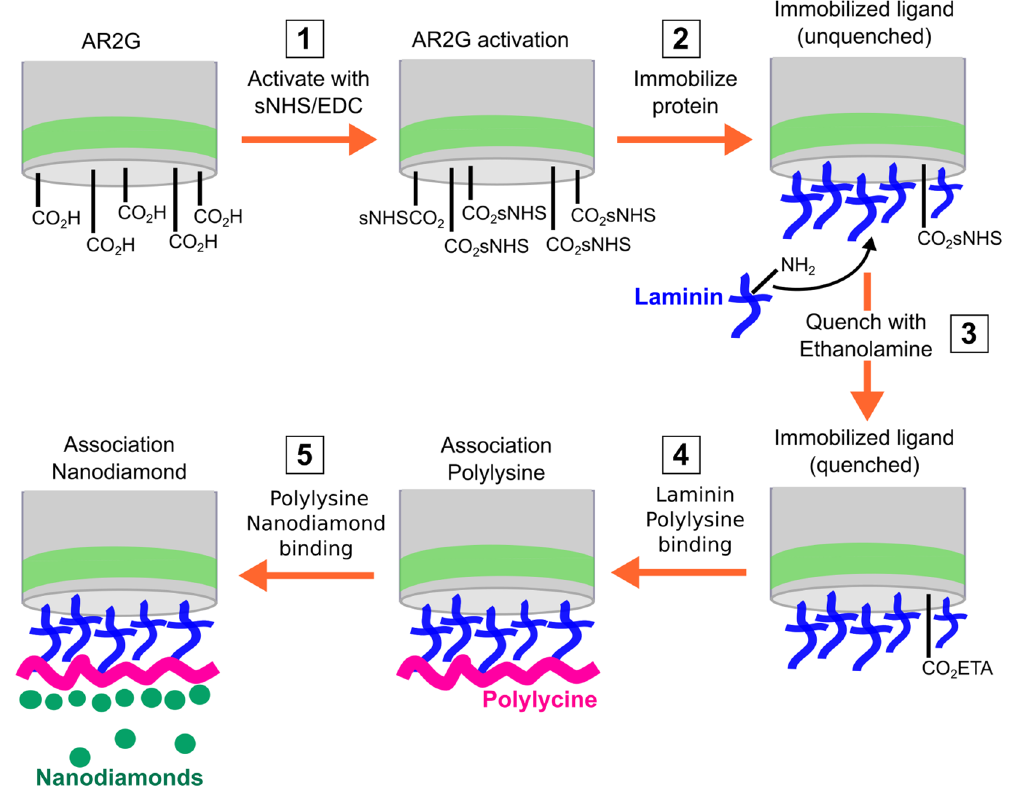
Figure 8. Schematic outlining the covalent immobilization process of laminin onto AR2G coated biosensors, and subsequent binding of poly-L-lysine and nanodiamonds. Step 1: EDC catalysis activates carboxylic acid coated sensor by facilitating the reaction with sNHS, resulting in a more reactive carboxylic acid site. Step 2: LN is covalently immobilized onto the sensor. The covalent bond is formed between a reactive amine group on the laminin and the carboxyl–functionalized surface of the biosensor. Step 3: ethanolamine is used to quench all remaining carboxylic activated groups on the sensor head to prohibit non–specific binding. Step 4: poly-L- lysine is bound to the laminin coated sensor, the thickness of this is measured using Bio–layer Interferometry. Step 5: nanodiamonds are bound to the poly-L-lysine, the binding thickness is also measured using Bio–layer